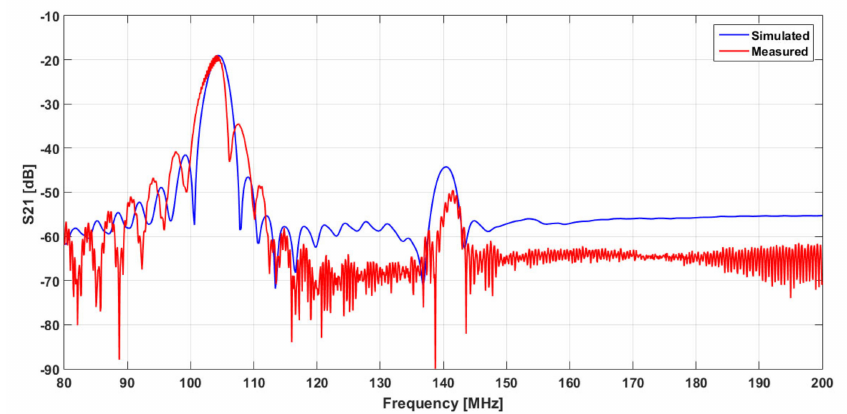
Figure 4. Simulated (3D model COMSOL, configuration: 30 pairs of double fingers + metallized sensing area of 80 µ m length) and measured S21 spectra of SAW delay